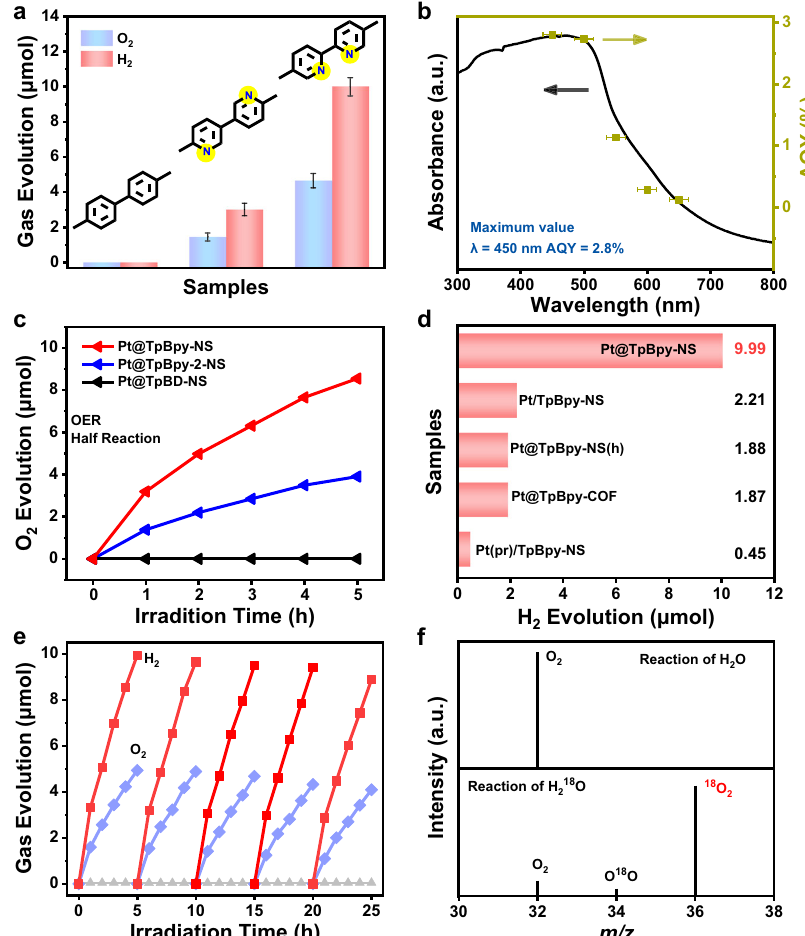
Fig. 3 | Photocatalytic performances of COFs-NS. a Overall water splitting activ- ities comparison over Pt@COFs-NS. The error bar represents the standard devia- tion of the measurements. b Wavelength dependent AQY of overall water splitting forPt@TpBpy-NS.Theerrorbarsindicatetheincidentwavelengthwithafullwidth